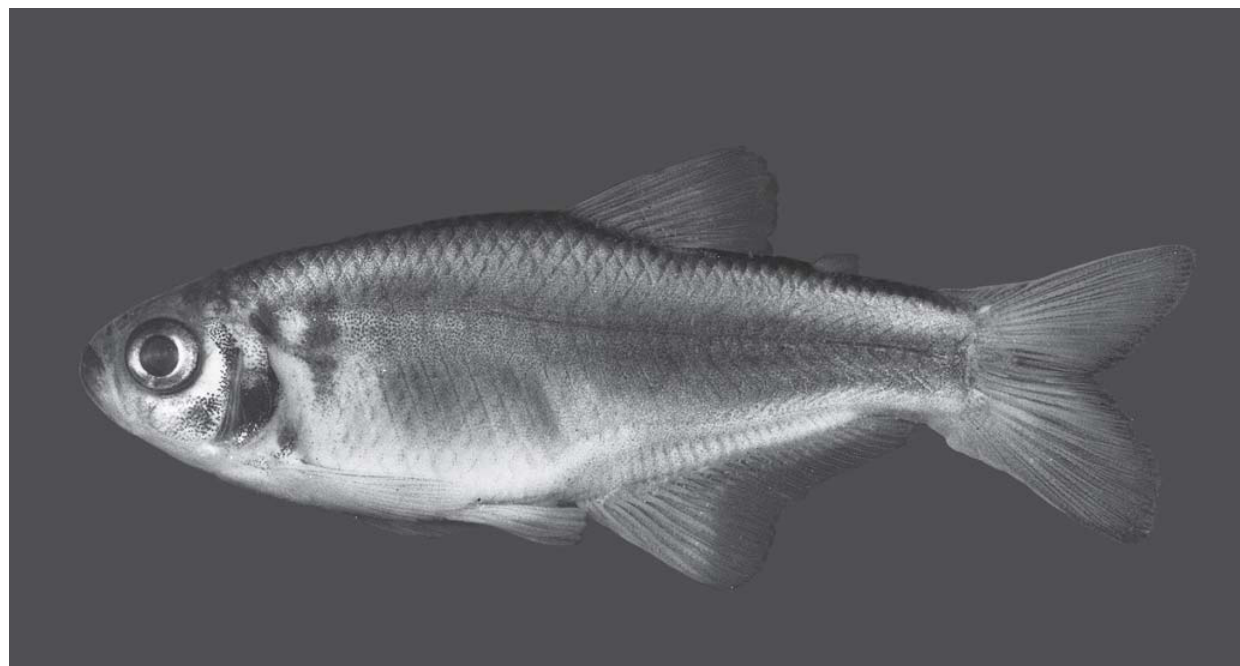
Fig. 11. Glandulocauda melanopleura , adult male. USNM 236415, 42.3 mm SL, Brazil, São Paulo State, headwater stream of rio Tietê near Paranapiacaba. Modified from Weitzman et al . (1988).